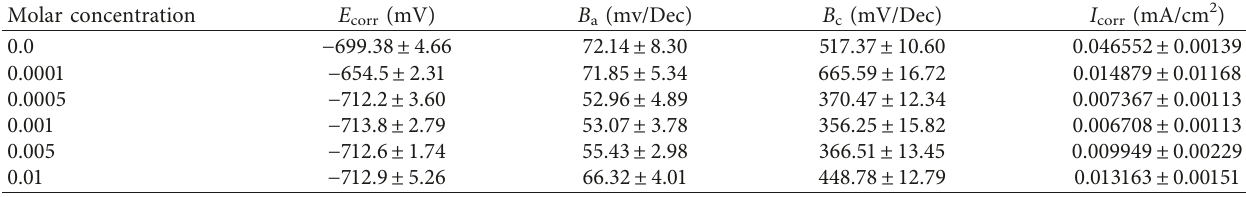
Figure 8: Cathodic polarization curves for API X70 steel in 3.5% NaCl solution at different concentrations of inhibitor obtained from permanent magnets. Table 1: Electrochemical parameters and standard deviation of the polarization curves as a function of the inhibitor concentration obtained from permanent magnets.